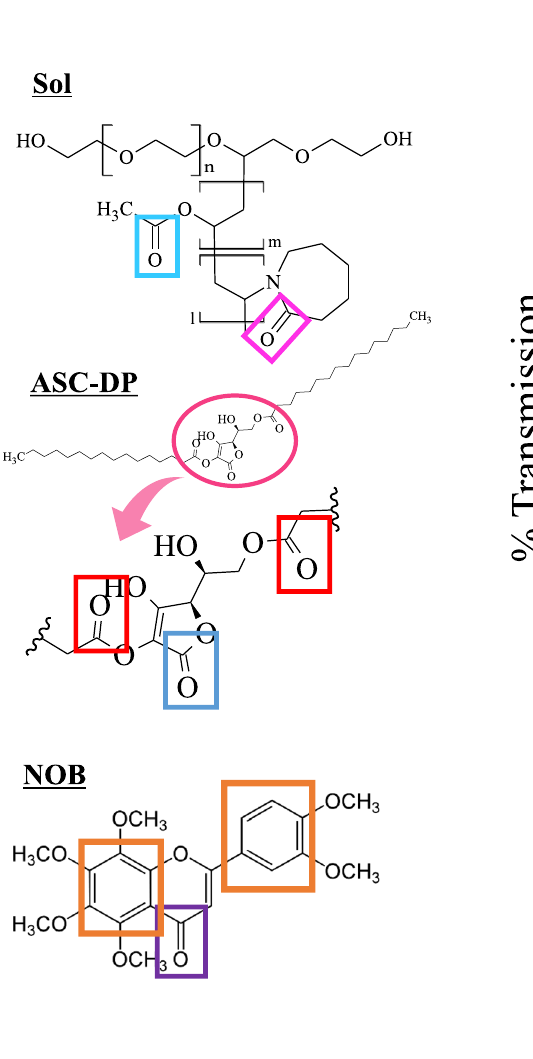
8/2), e EVP (Sol/NOB = =